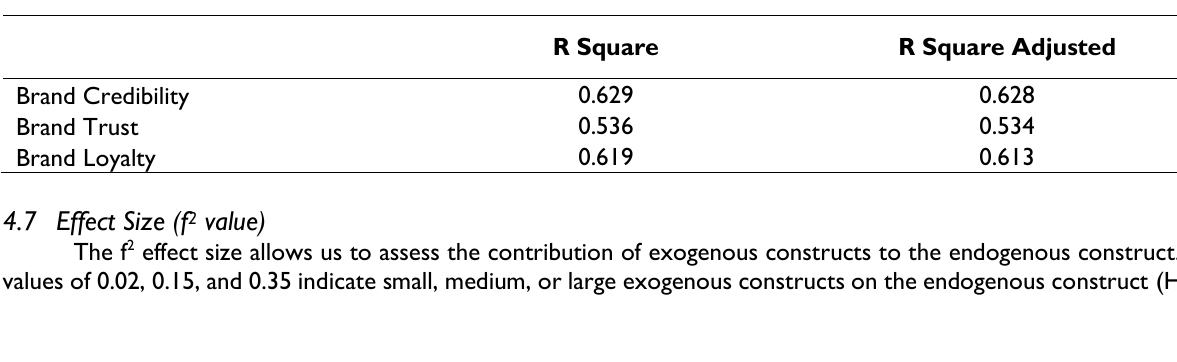
Table 6. Coefficient of Determination (R 2